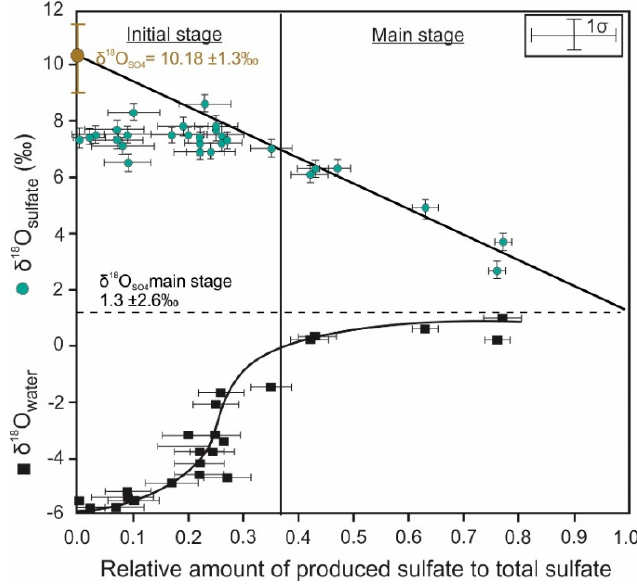
Figure 6. δ 18 O variations of sulfates and interacting water as a function of the increasing amount of sulfate during pyrite leaching. The dashed line shows the δ 18 O values of sulfate that are produced in the main stage of dissolution. The gold circle illustrates the supposed δ 18 O value of initial sulfates in the case of immediate conversion of sulfite to sulfate. The vertical line demonstrates the transition from initial to the main stage of pyrite leaching. Redrawn from Brunner et al. [78]. Based on the above, the major potential factors that are considered to cause variations in